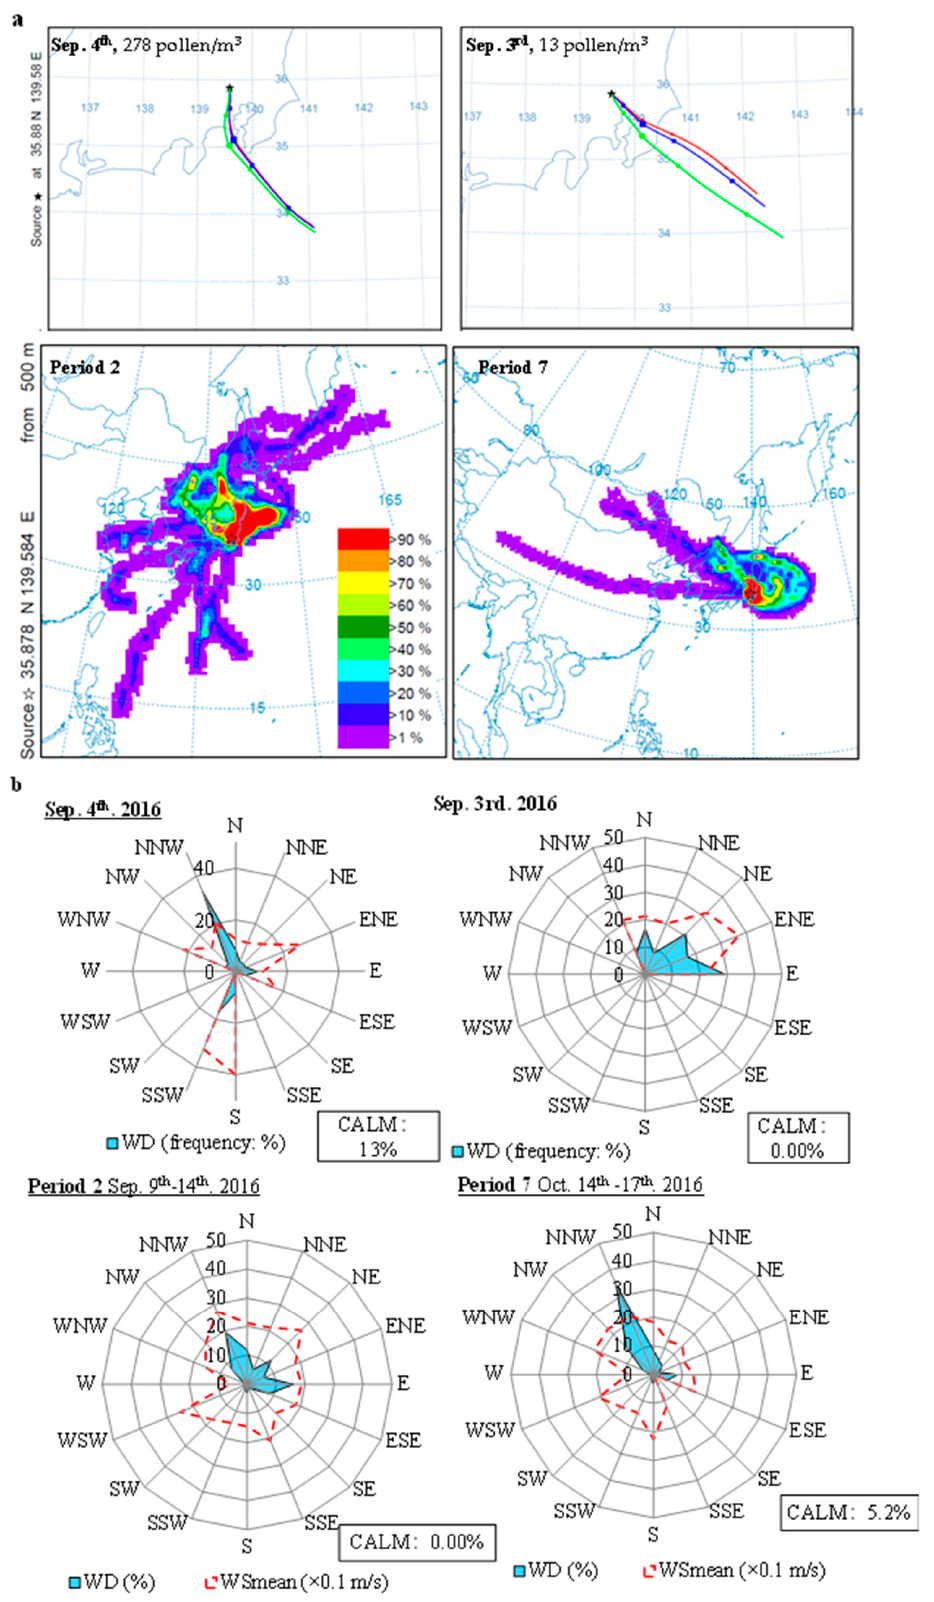
Figure 4. ( a ) The air mass trajectories on September 4th and September 3rd; period 2 and period 7; ( b ) the wind roses and directions on September 4th and September 3rd event; period 2 and period 7.